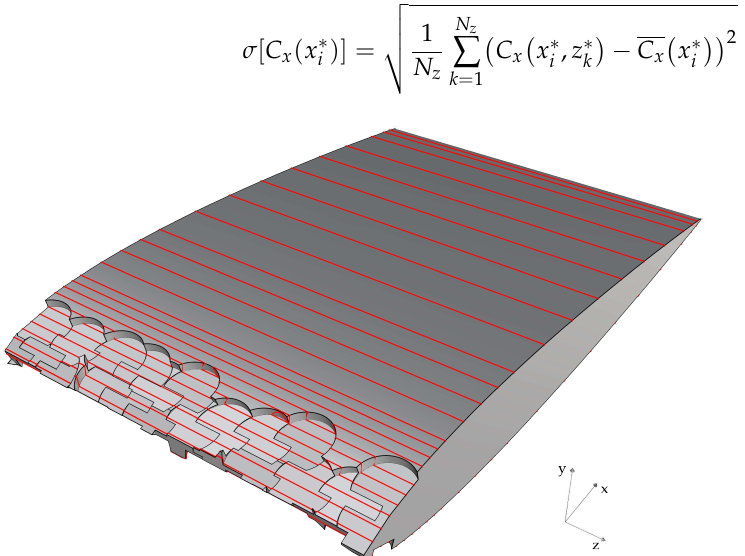
Figure 17. Geometrical representation of the lines where friction and pressure coefficient are